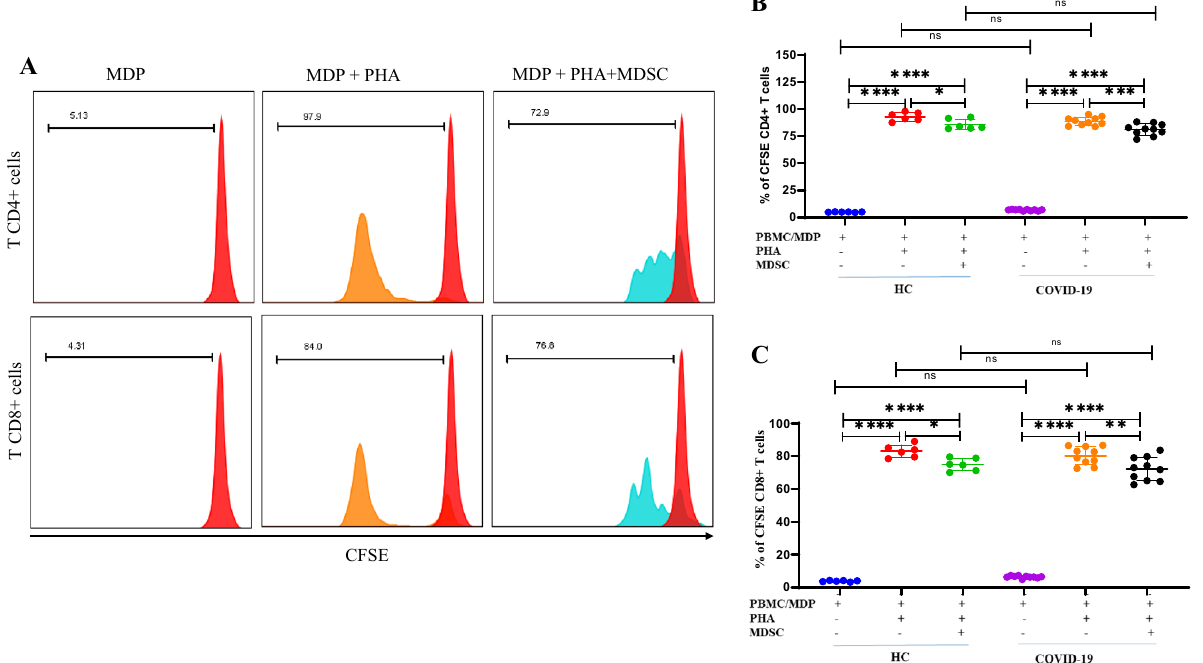
Figure 3. Isolated MDSCs, suppressed CD4 + and CD8 + T cells response in vitro. MDSCs isolated from fresh PBMC of the patients co-cultured with CFSE labeled-autologous MDPs from the patients and CFSE labeled- homologous PBMCs from HCs in the presence of PHA for 5 days. ( A ) Histograms show representative CD4 + and CD8 + T cell proliferation as assessed by CFSE dilution and flow cytometry. The numbers in the plots indicate the frequency of proliferating T cells. The unstimulated MDPs are indicated in red, PHA-stimulated MDPs are indicated in orange and PHA-stimulated MDPs in presence of MDSCs are indicated in blue. ( B,C ) Dot plots show the percentage of proliferating CD4 + and CD8 + T cells from 10 COVID-19 patients and 6 HCs. All values are presented as the mean and 5–95% percentile and comparisons made between control and patient groups were performed using ANOVA followed by a Tukey’s test. *P < 0.01, **P < 0.001, ***P < 0.0001 and